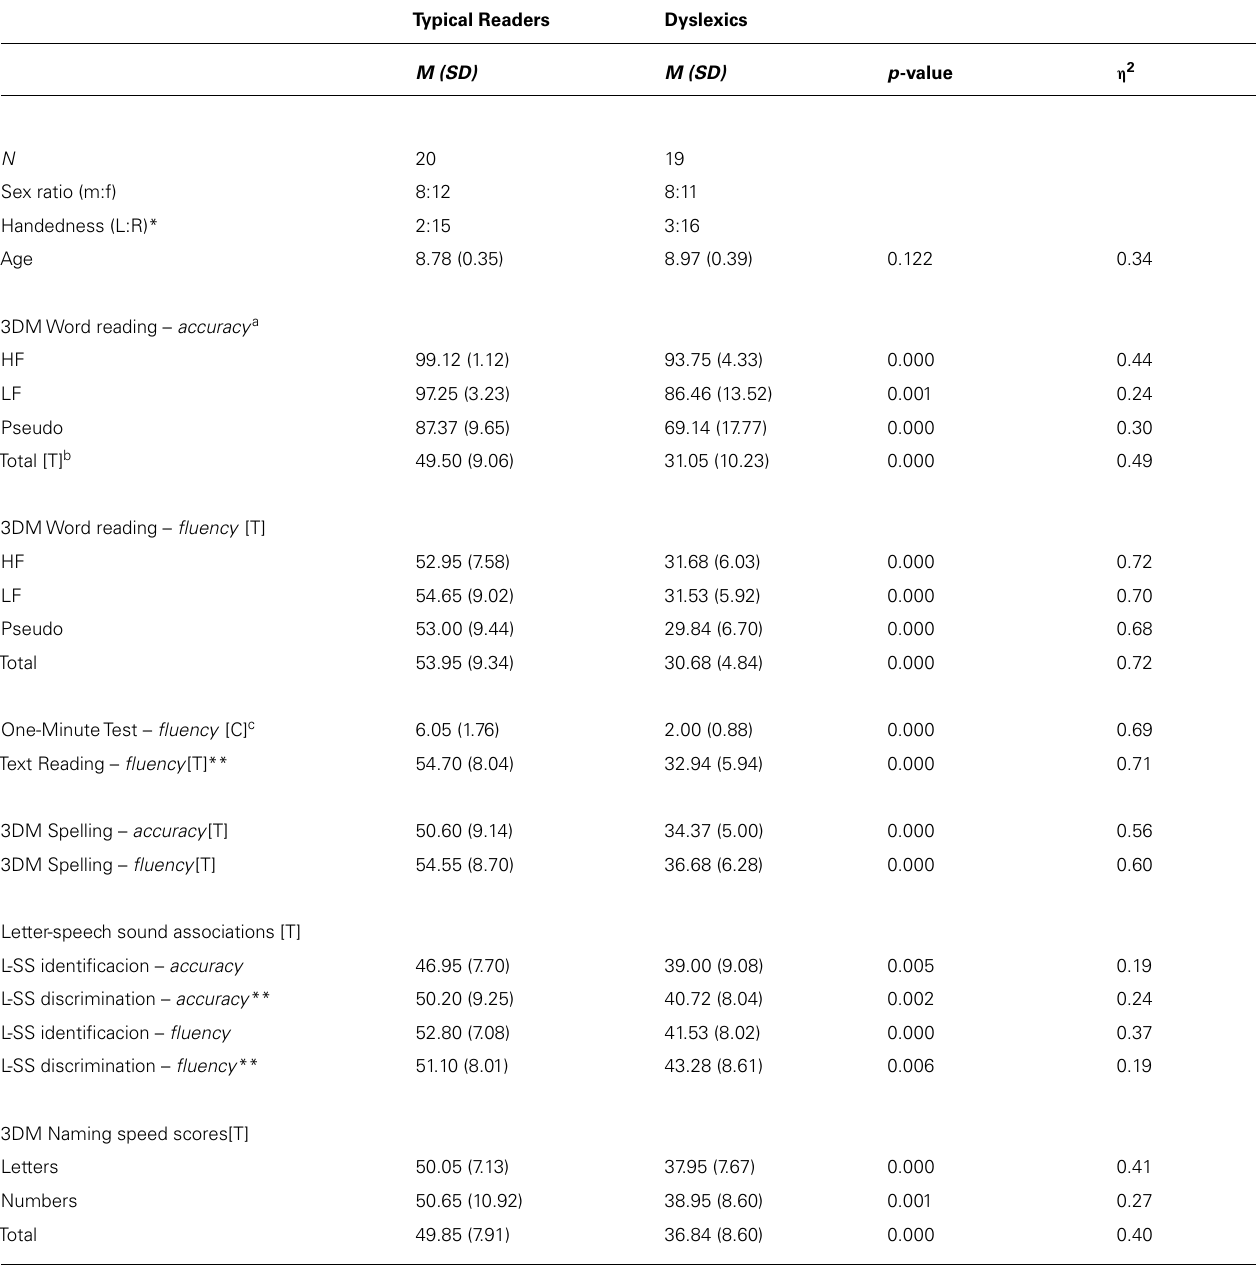
Table 1 | Descriptive statistics showing reading accuracy and fluency scores.